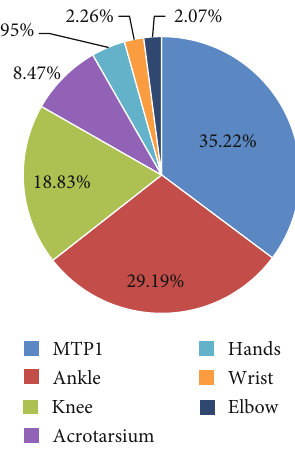
Figure 1: Clinical characteristics of gouty attacks in the gout